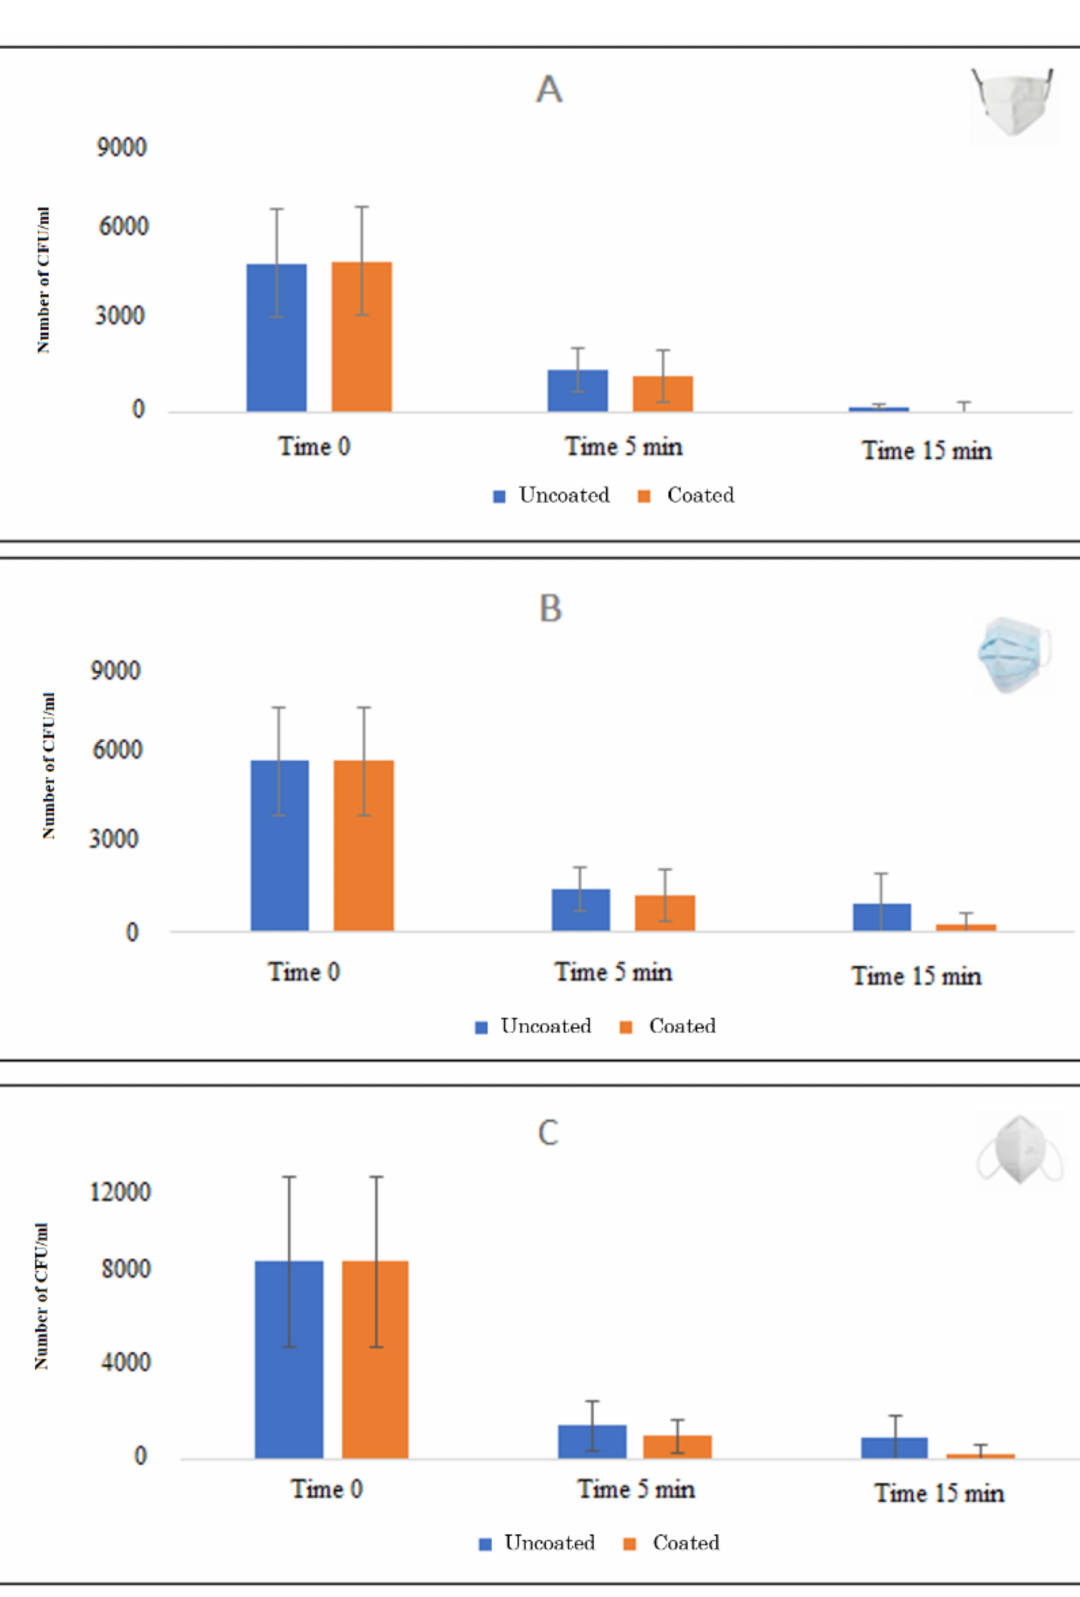
Figure 5. Blue light antibacterial activity on different masks. TiO 2 treatment shows enhancement of the antibacterial activity on different mask materials. Quantification of E. col i bacterial cell viability at different times after blue light exposure (Time 0, Time 5 min, and Time 15 min) with (coated) and without TiO 2 -coating (uncoated). CFU: colony forming units. ( A ): cloth face mask; ( B ): surgical mask; ( C ): FFP2